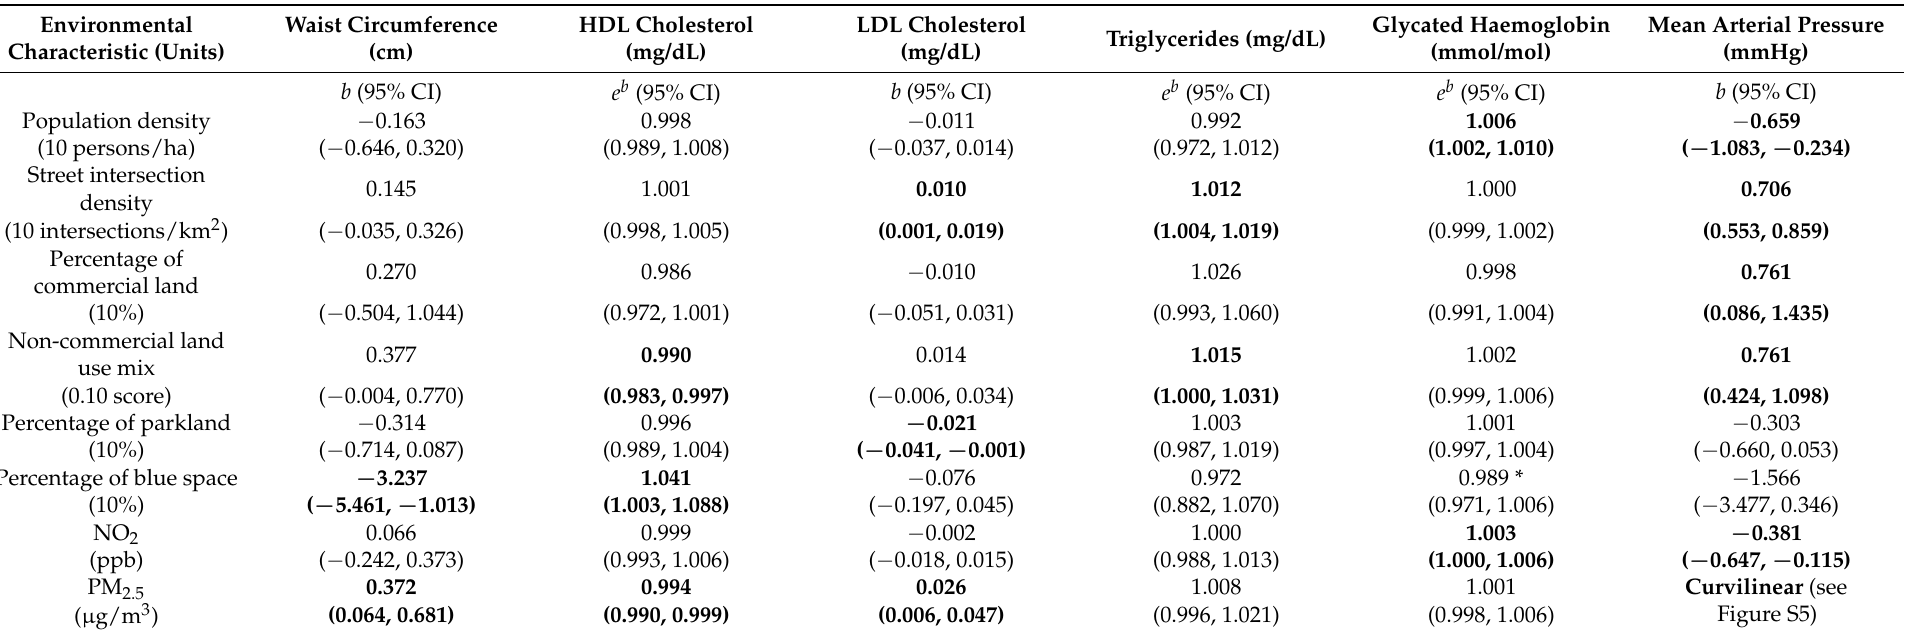
Table 2. Total effects of neighbourhood environmental characteristics on cardiometabolic risk